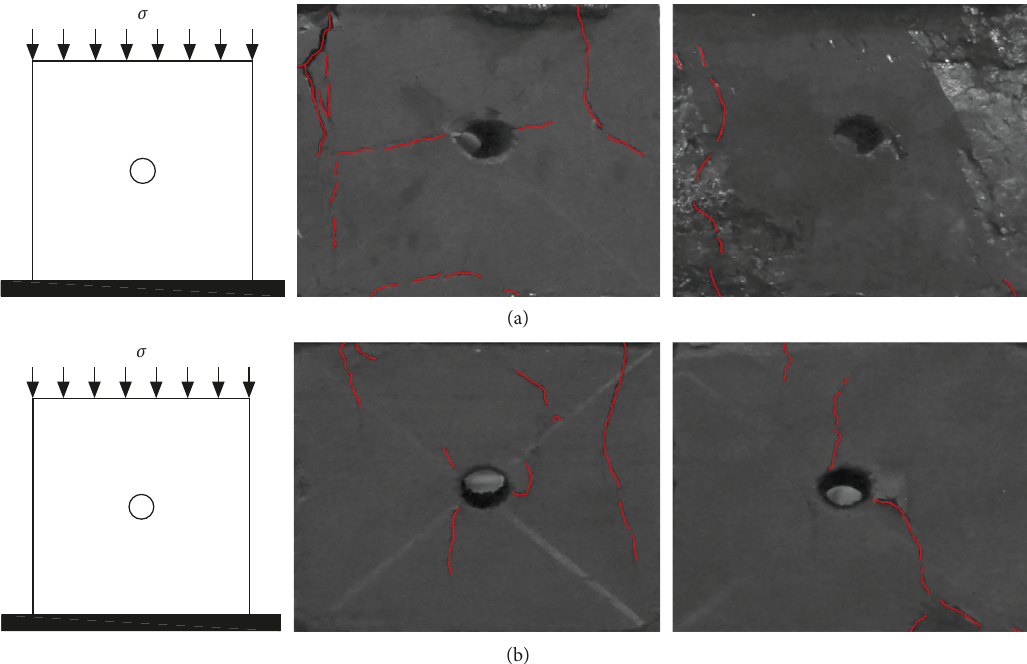
Figure 6: Action area of S. (a) Coal samples; (b) briquette samples.